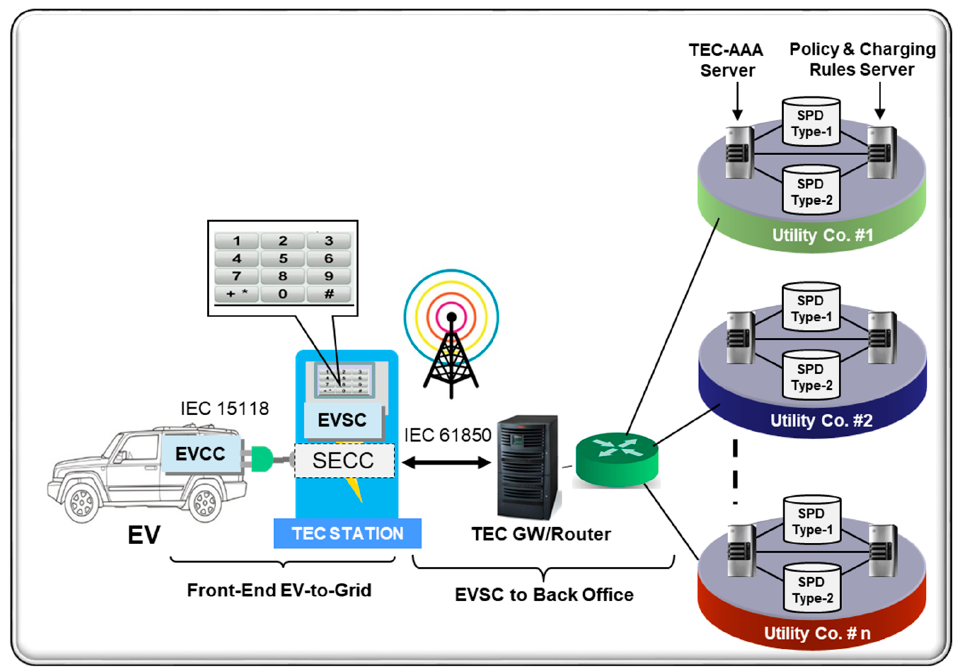
Figure 1. Architecture of toll-free electric vehicle charging (TEC) system.